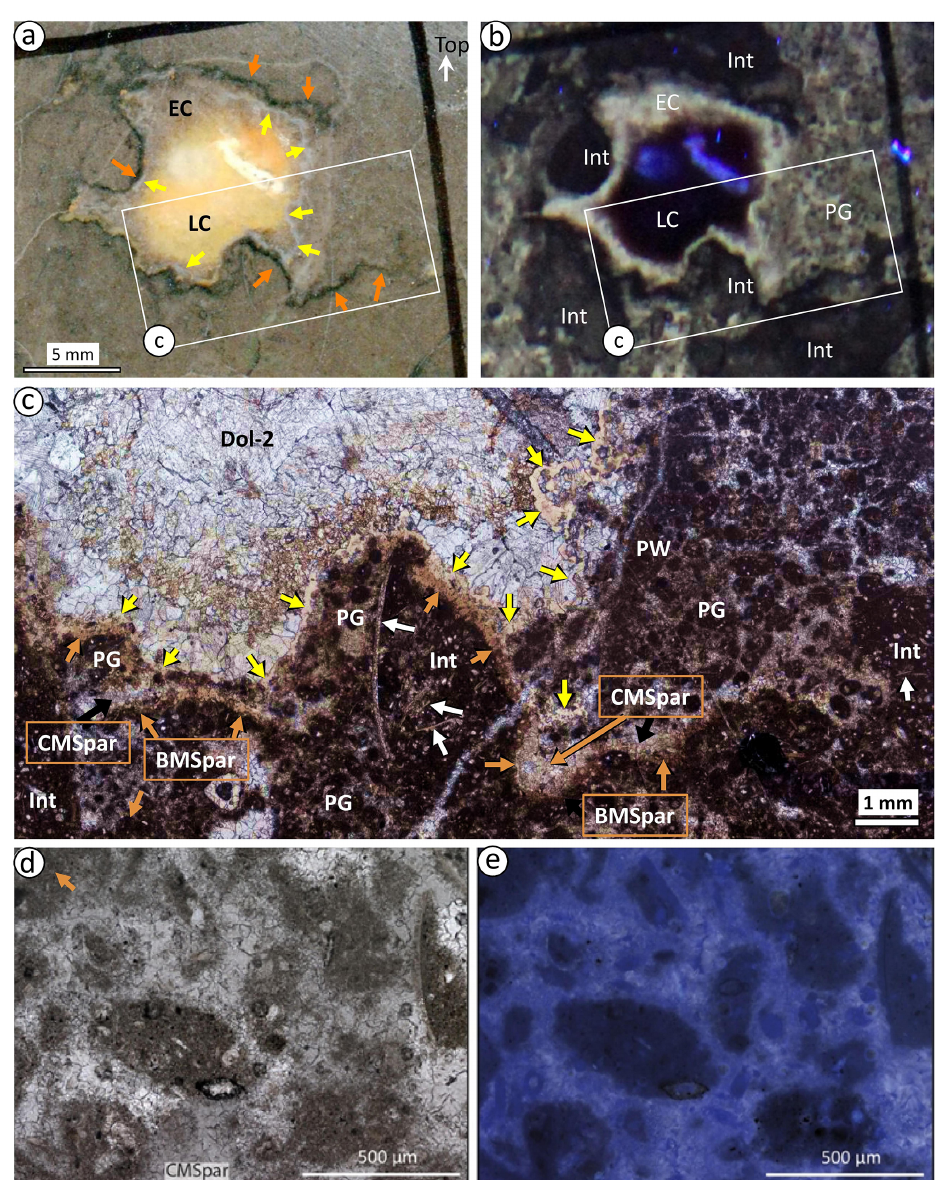
Figure 10. (a, b) Close-up of Fig. 8a and b showing the details of burrow infill; white rectangle marks the position of the thin section close-up in (c) . (a) Natural light view; EC: early cements, LC: late cements; the orange arrows mark a dark halo surrounding the burrow on the left side and opening into sediment on the right side; yellow arrows mark a thin, continuous, milky white cement rim following the dark halo on the left side of the image but following the sediment-cement contact on the right side. (b) UV fluorescence view indicates that the fluorescent halo expands on the right side into peloid grainstone (PG); the blurry appearance results from the diffusion of light emitted from fluorescent parts into non-fluorescent ones; Int: micrite pheno-intraclasts; pheno-intraclasts, like nodules in F2 and F3 exhibit a low level of fluorescence. The brightly fluorescent zone is bounded by the dark rim on the outer side (orange arrows in a ) and the white rim on the inner side of the burrow (yellow arrows in a ). (c) Microphotograph of the sample shown in (a) and (b) (plane-polarized light view); the dark halo (orange arrows) corresponds to the superposition of brown and clear microsparite layers (BMSpar and CMSpar, respectively), with BMSpar directly covering the burrow wall. The white rim (yellow arrows) consists of beige chalcedony (for details, see Fig. 11). The white arrows point to shell fragments, PW: peloid wackestone, Dol-2: late saddle dolomite. (d, e) Photomicrographs of peloid grainstone in F4. (d) Internal texture of the peloids in plane-polarized light; (e) As (d) in UV epifluorescent light.